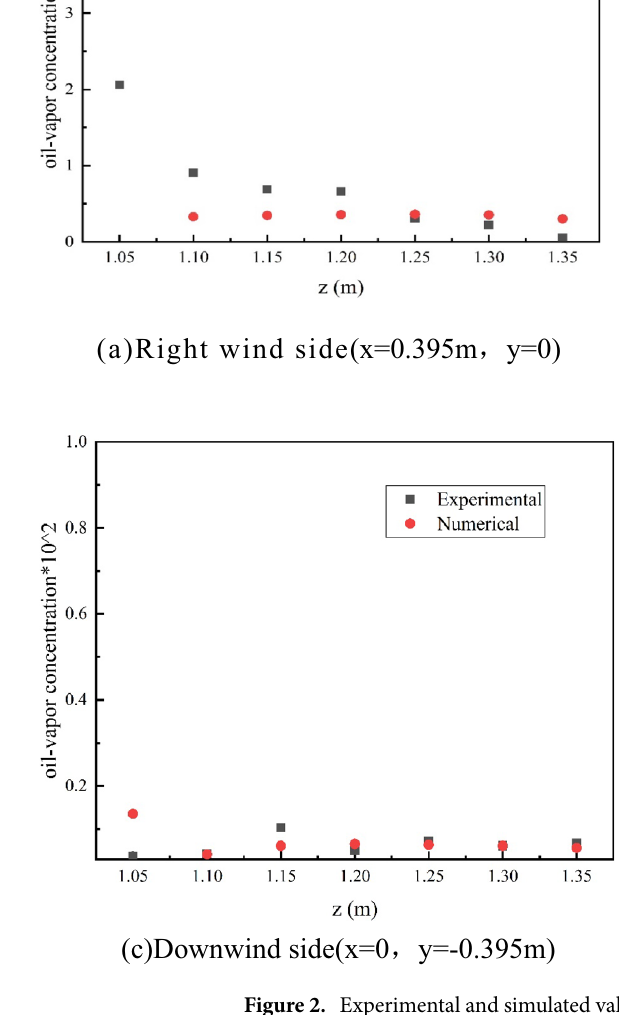
Figure 2. Experimental and simulated values of petroleum gas concentration in the space above the floating